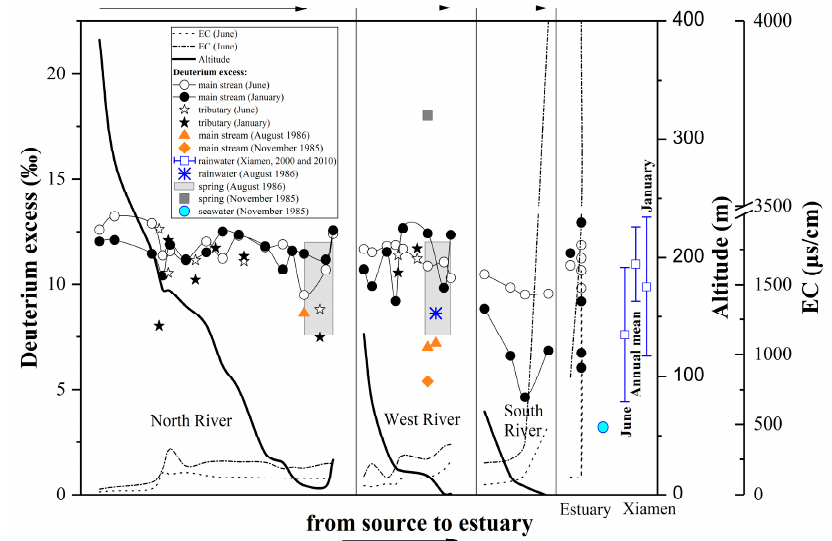
Figure 5. Spatial and seasonal variation of deuterium excess of river water, rainwater and spring in the Jiulong River basin. The d -excess values of rainwater were quoted from references [36,42,44]. The d -excess values of spring were quoted from references [36]. The d -excess value of seawater was quoted from reference [36].